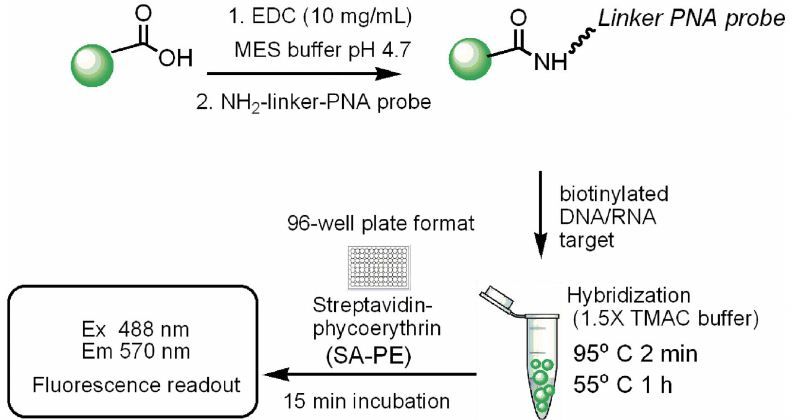
Figure 4. Conjugation of PNA probes and generalized scheme for the Luminex fluorescence bead assay.